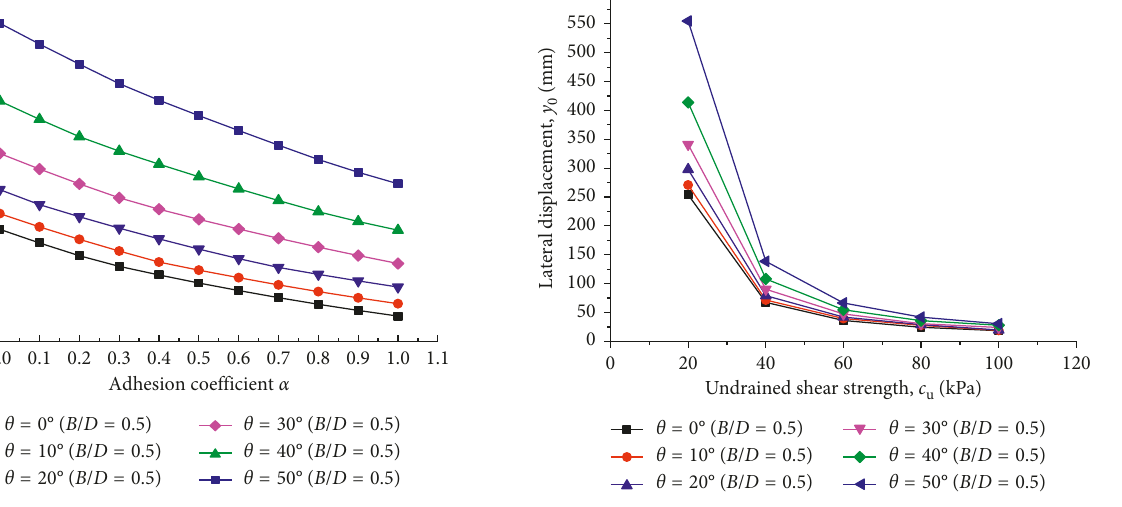
max ) variation with